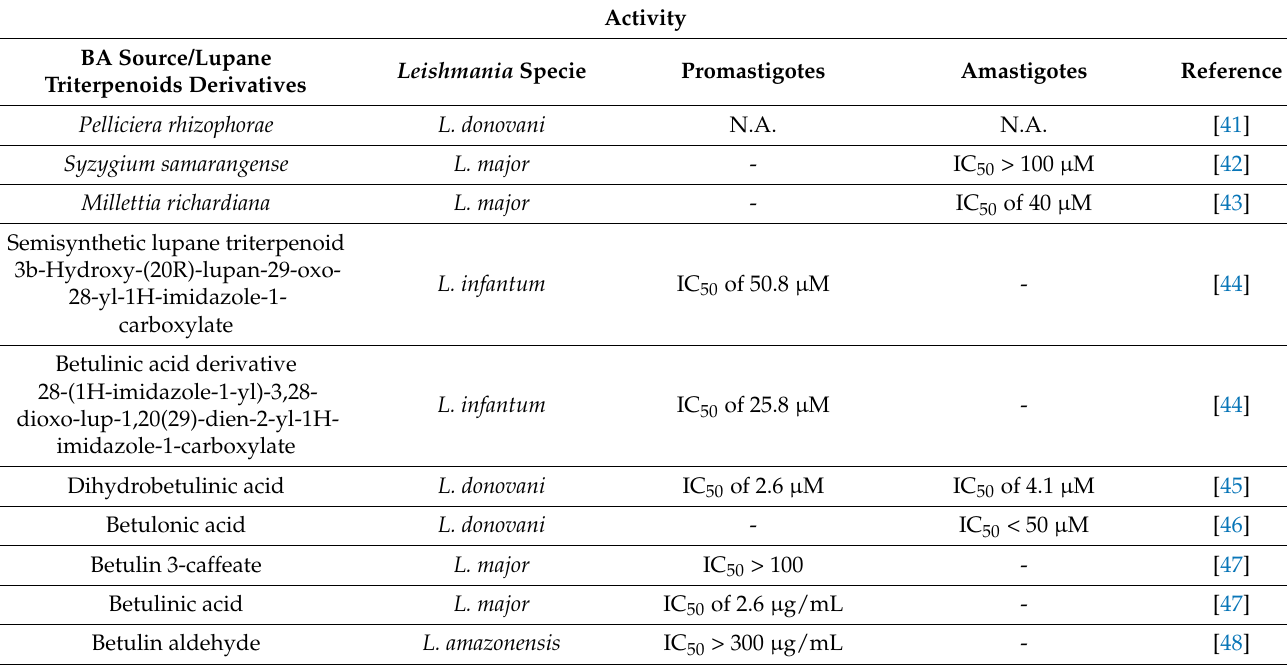
Table 1. Summarized activity of betulinic acid against Leishmania